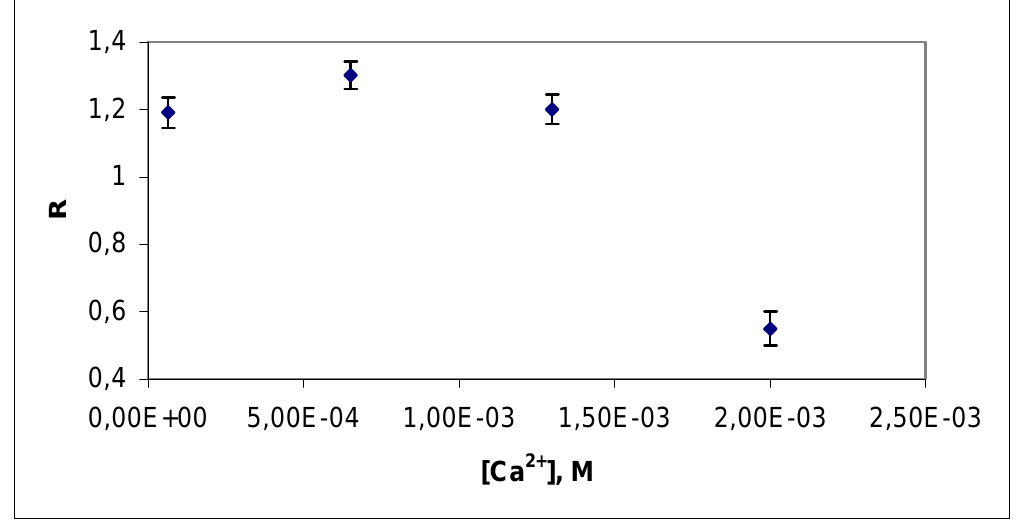
Figure 3: Dependence of the enzymatic specificity (R) on Ca 2+ concentration. R is the A ratio in absence and presence of the corresponding Ca 2+ concentration. (A acids; A : unsaturated fatty acids). Incubation time: 25 min at the conditions described in the 2